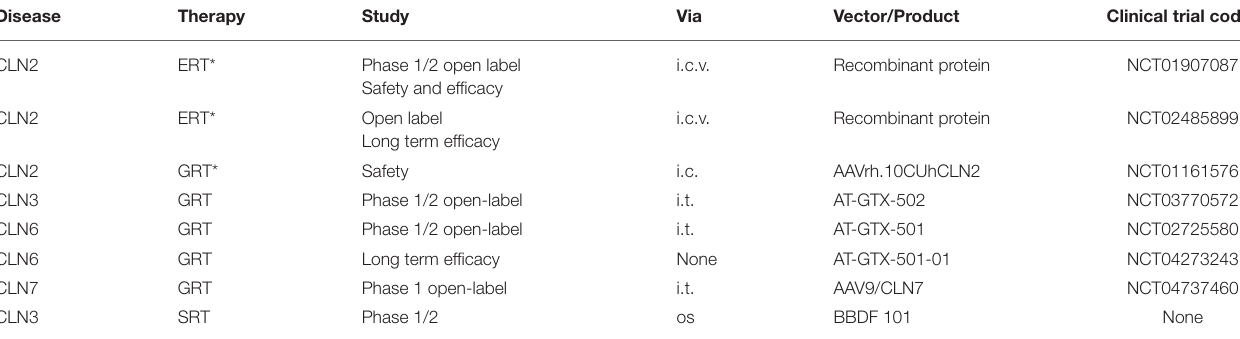
TABLE 4 | Selected therapeutic trials (completed and on-going). Disease